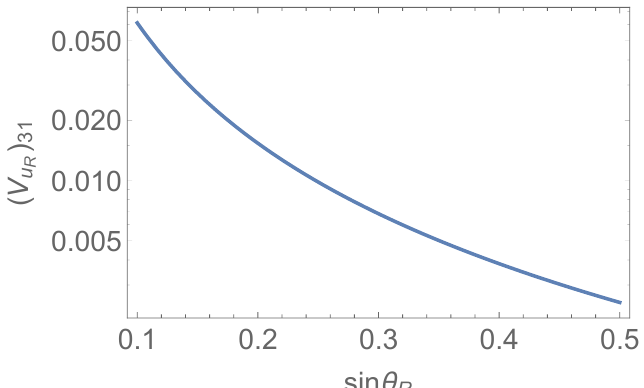
Figure 5 . Upper bound on ( V u ) 31 as a function of sin (cid:18) R from condition (4.29) for m 1 =3 TeV, R using the value of ( V y ) 23 provided by R D ( (cid:3) ) u R